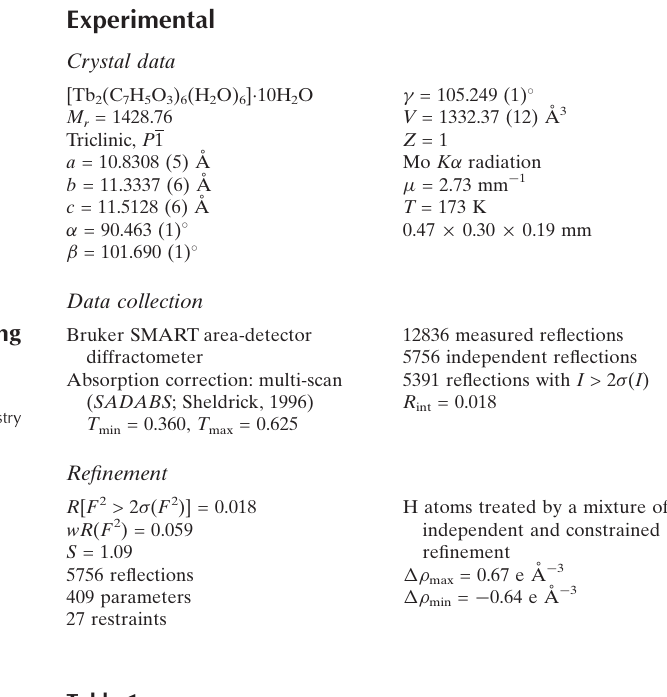
The title dinuclear compound, [Tb lies on a center of inversion and the two Tb III atoms are bridged by two 4-hydroxybenzoate anions; each metal atom is further coordinated by one monodentate anion and chelated by the third anion. The eight-coordinate geometry approx- imates a square antiprism. Hydrogen bonds of the O—H (cid:2) (cid:2) (cid:2) O type connect the uncoordinated water molecules to the dinuclear species, forming a three-dimensional network. Related literature Zhou et al. (2008).